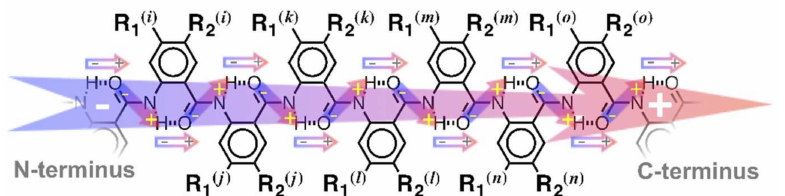
Figure 1. Bioinspired molecular electrets composed of anthranilamide (Aa) residues and the origin of their macrodipoles from ordered arrangement of amides and polarization upon the formation of hydrogen